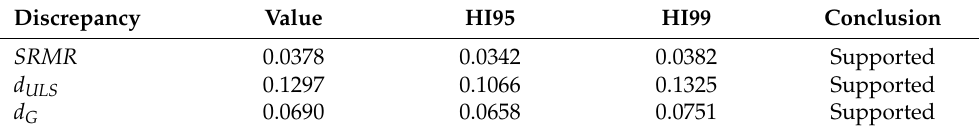
Table 4. Results of the estimated model goodness of fit.